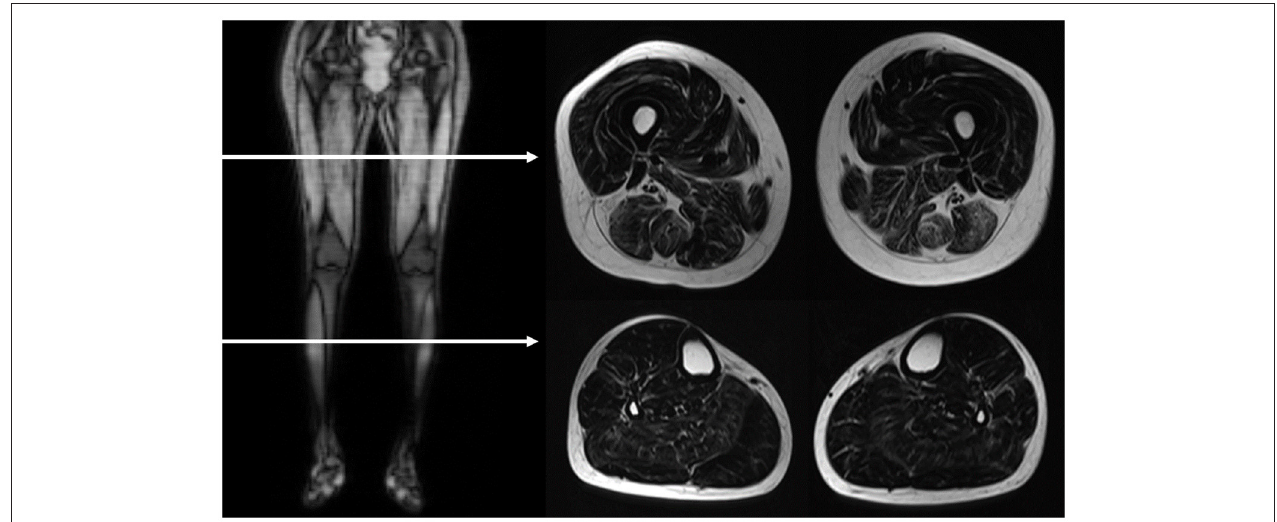
FIGURE 1 | MRI image acquisition. The horizontal arrows in the right side coronal T1-weighted image demonstrated the level of assessed planes, as showed in the left T2-weighted Dixon fat-only axial images. The scanning slices are at the mid-portion of the thigh and the thickest portion of the